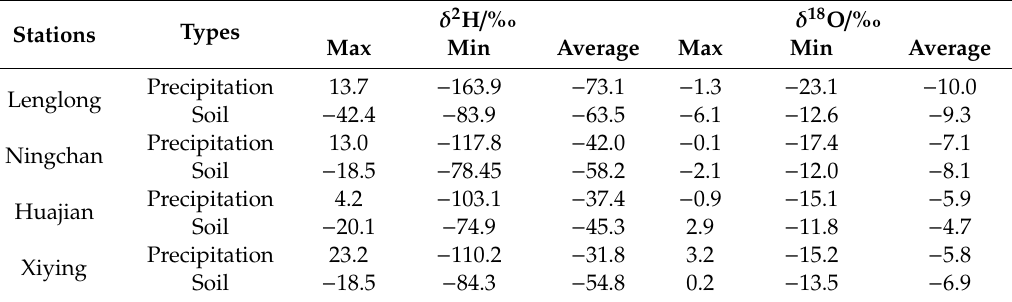
Table 2. Isotopic composition of each water at four stations in the Xiying River